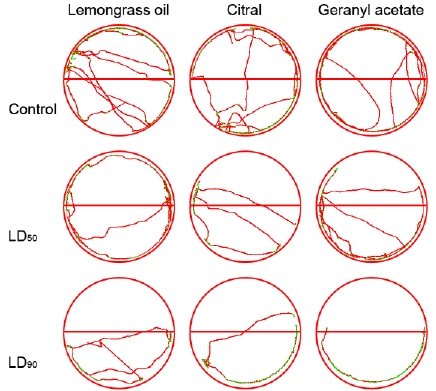
Figure 5. Representative tracks showing the walking activity of S. granarius over a 10-min period on filter paper arenas half-impregnated with lemongrass oil, citral, and geranyl acetate (upper half of each arena). Red tracks indicate high walking velocity; green tracks indicate low (initial) velocity.